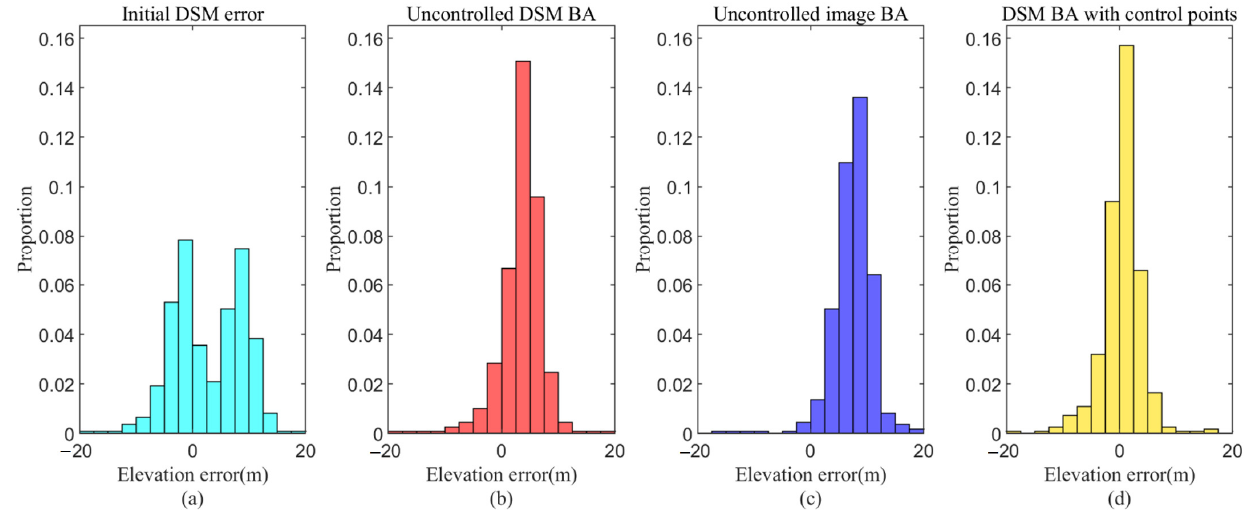
Figure 4. Histograms of check point elevation error for the ZY-3 DSMs. ( a ) before block adjustment, ( b ) uncontrolled DSM block adjustment, ( c ) uncontrolled images block adjustment, and ( d ) controlled DSM block adjustment. Table 2. Accuracy of the ZY-3 DSMs before and after block adjustment (BA) (unit: metre).